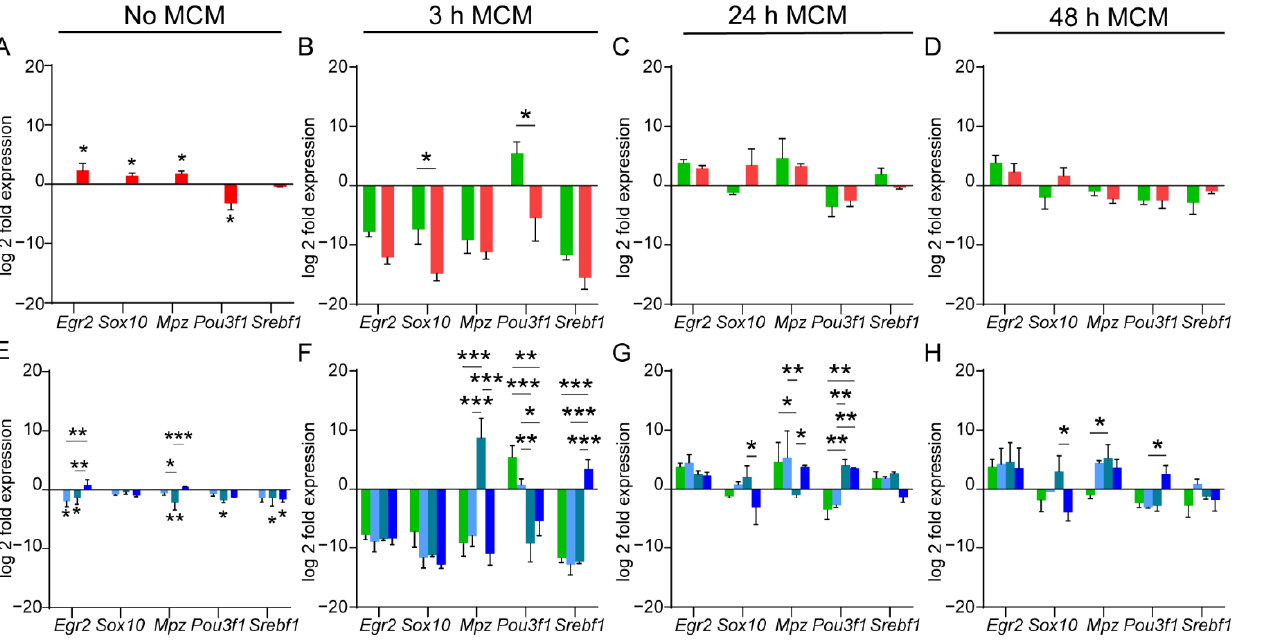
Figure 5. Effect of unconditioned and macrophage conditioned media (MCM) with or without VEGF, PDGF on myelination associated gene expression in primary OECs. ( A – L ) Graphs represent the log 2-fold expression of genes responsible for myelination in OECs when treated with uncondi- tioned media (No MCM), 3 h, 24 h and 48 h MCM. ( A – D ) Untreated control and IFN- γ + LPS media for ( A ) Unconditioned media, ( B ) 3 h MCM, ( C ) 24 h MCM, ( D ) 48 h MCM ; ( E – H ) Untreated control vs. VEGF vs. PDGF vs. combined VEGF + PDGF ( E ) Unconditioned media, ( F ) 3 h MCM, ( G ) 24 h MCM, ( H ) 48 h MCM; ( I – L ) IFN- γ + LPS vs. IFN- γ + LPS + VEGF vs. IFN- γ + LPS + PDGF vs. IFN- γ + LPS + VEGF + PDGF for ( I ) Unconditioned media, ( J ) 3 h MCM, ( K ) 24 h MCM, ( L ) 48 h MCM. Normalisation was done on no MCM control data. * p ≤ 0.05, ** p ≤ 0.01, *** p ≤ 0.001 measured using unpaired t-test for ( A – D ); two-way ANOVA with Fisher’s LSD test for ( E–L ). Error bar represents mean ± SEM for three technical replicates of three biological replicates. 4. Discussion This study has assessed how macrophage conditioned medium affects the phagocytic ability and gene expression pattern in OECs and the influence of the growth factors VEGF and PDGF. Macrophages exposed to combined VEGF + PDGF for 24 h (Figure 1I) had reduced nuclear factor kappa B p65 translocation. Conditioned medium from macro- phages incubated with PDGF and combined VEGF + PDGF in inflammatory conditions promoted phagocytosis by OECs (48 h MCM; Figure 3K). The growth factor treated con- ditioned media also modulated the expression of genes associated with nerve repair and myelin expression in OECs. In the context of SCI, macrophages exist throughout all the phases of injury, progress- ing inflammation or promoting repair, where their actions are modulated by the presence